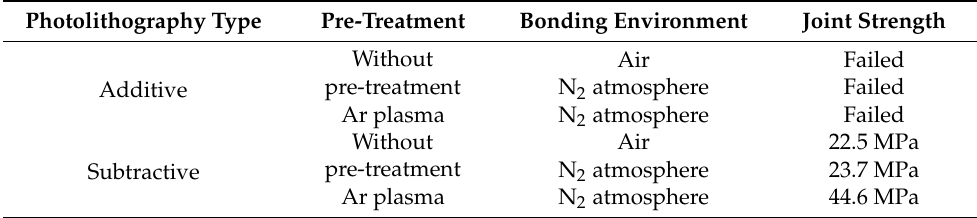
Table 2. Comparison of the ultrasonic bonding results of the LSB bumps created using subtractive lithography etching and additive lithography sputtering (the conditions of Ar plasma: 200 W − 50 sccm − 20